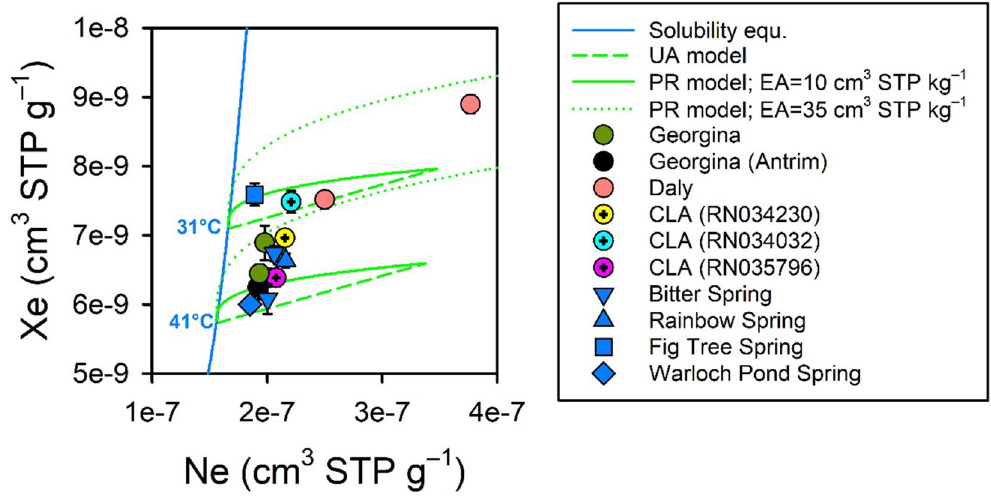
Figure 6. Ne and Xe trends at the Mataranka Springs Complex, showing that the relative warm temperatures of the springs are caused by the prevailing warm climate. Deviations from solubility equilibrium (blue line) are due to the presence of excess air (EA) in groundwater. The green lines represent the possible range in noble gas concentrations at a given recharge temperature using either the unfractionated excess air model (UA) or the Partial Re-equilibration (PR) excess air model (for two initial EA contents). Mean shown with ± one standard